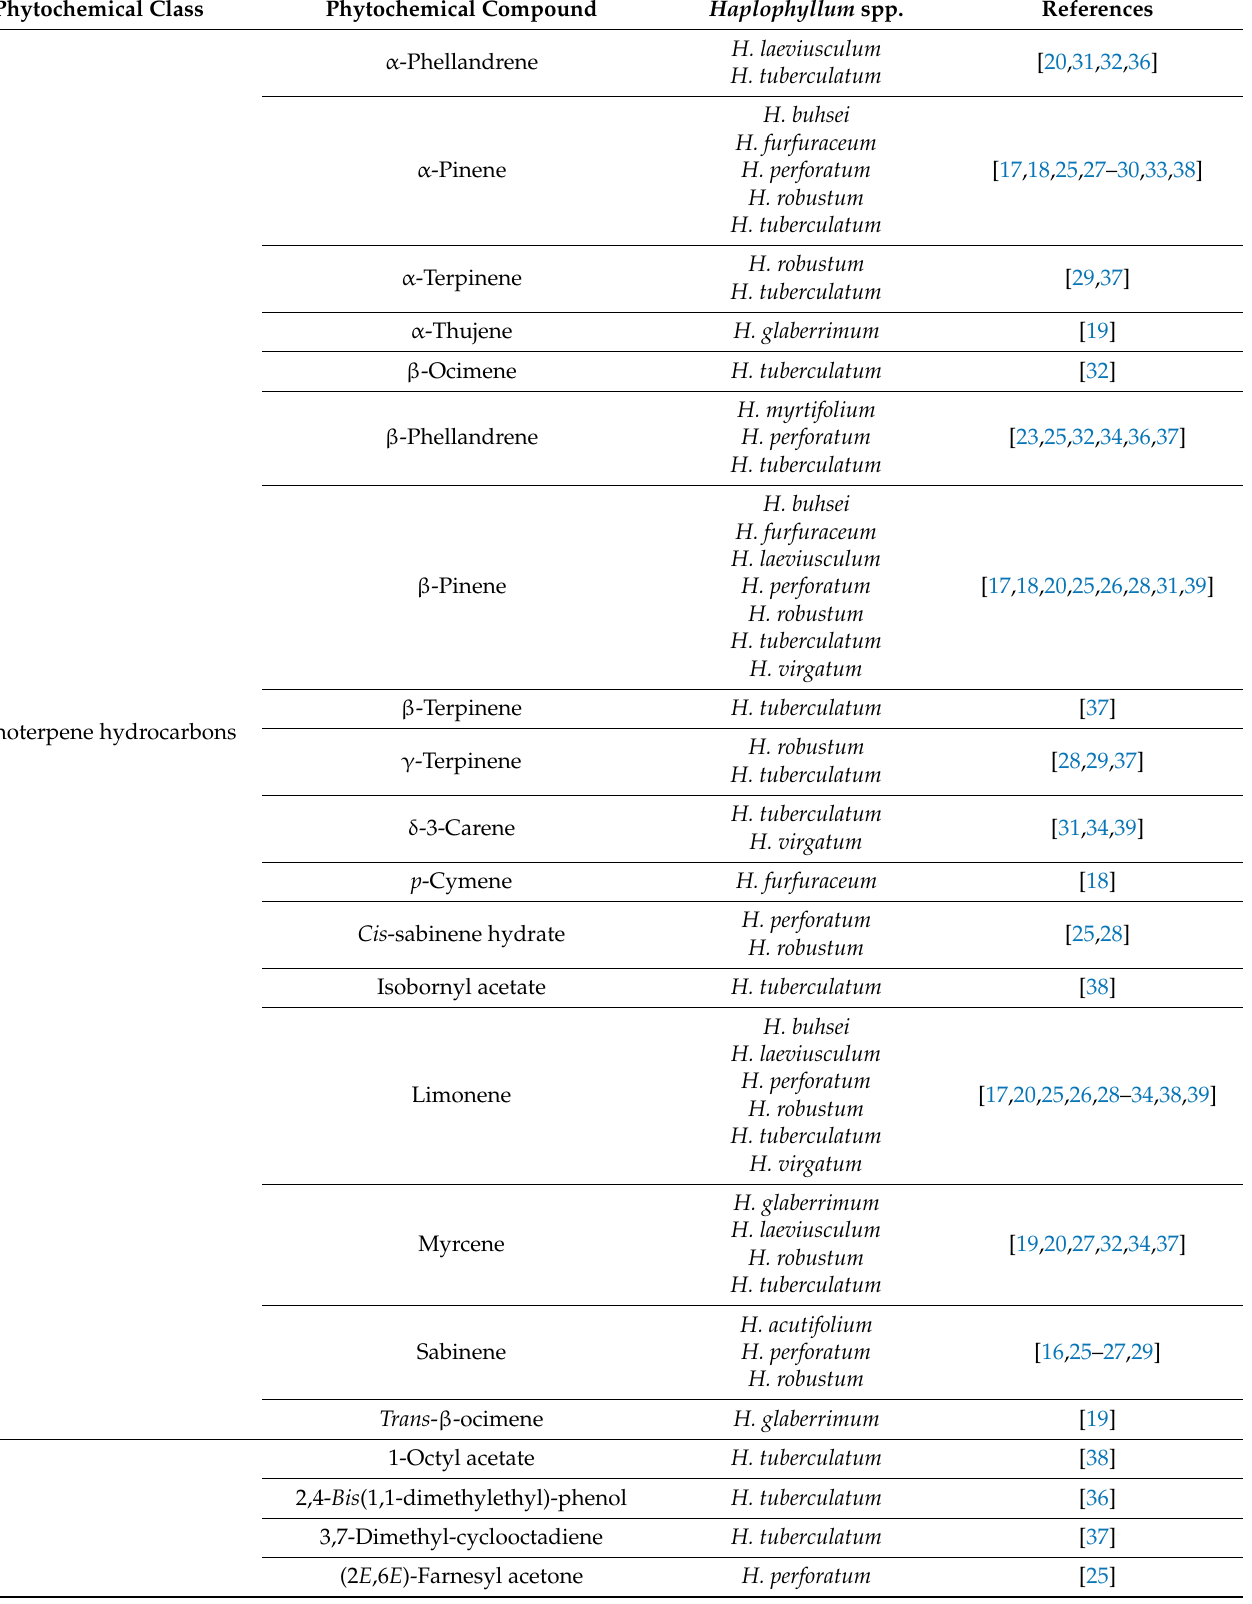
Table 2. Distribution of the main volatile phytochemicals in the Haplophyllum genus. Phytochemical Class Phytochemical Compound Haplophyllum